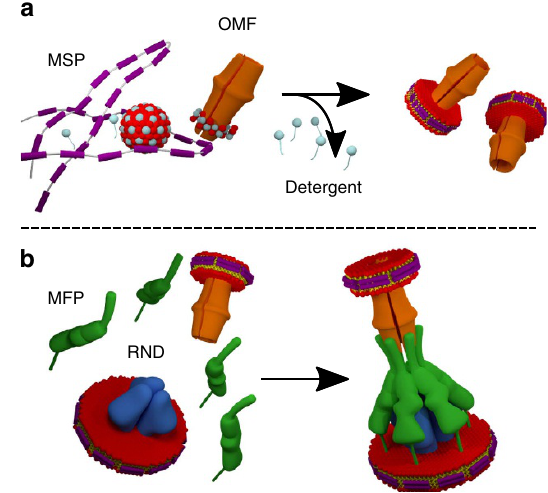
Figure 1 | Tripartite assembly based on RND and OMF inserted into nanodiscs. ( a ) After detergent removal, the integral membrane proteins are reconstituted into a small lipid bilayer wrapped by two MSPs (purple) forming the nanodisc. Lipids are red/yellow and detergent is grey. ( b ) Self-assembly of RND (blue) and OMF (orange) in nanodiscs in the presence of native lipid-modified MFP (green) leading to the tripartite complex in lipid